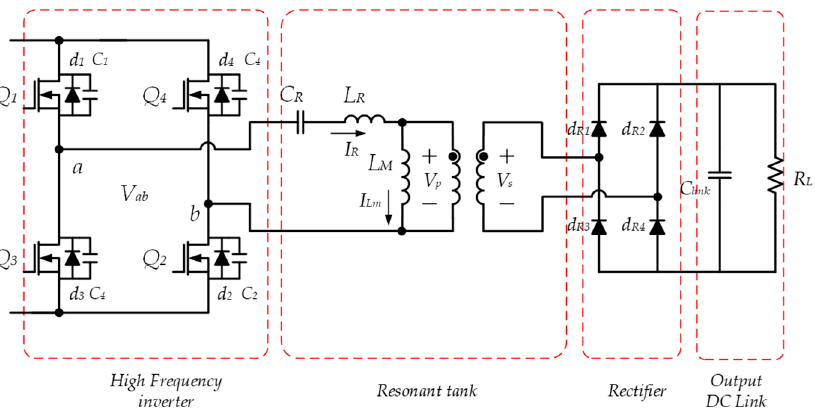
Figure 6. Full-bridge series resonant converter.